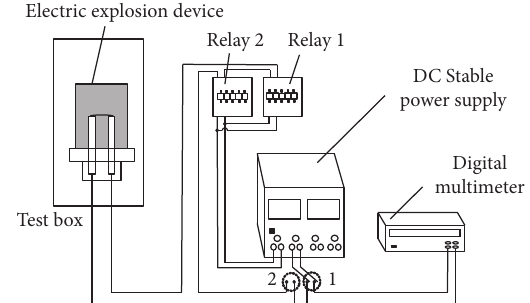
Figure 3: Schematic diagram of the ignition excitation test system for